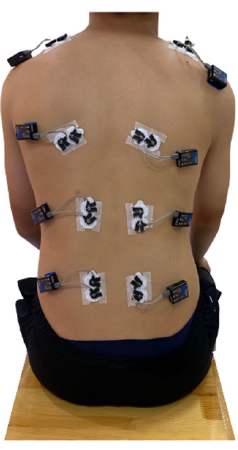
Figure 3. EMG test while sitting (static condition) .